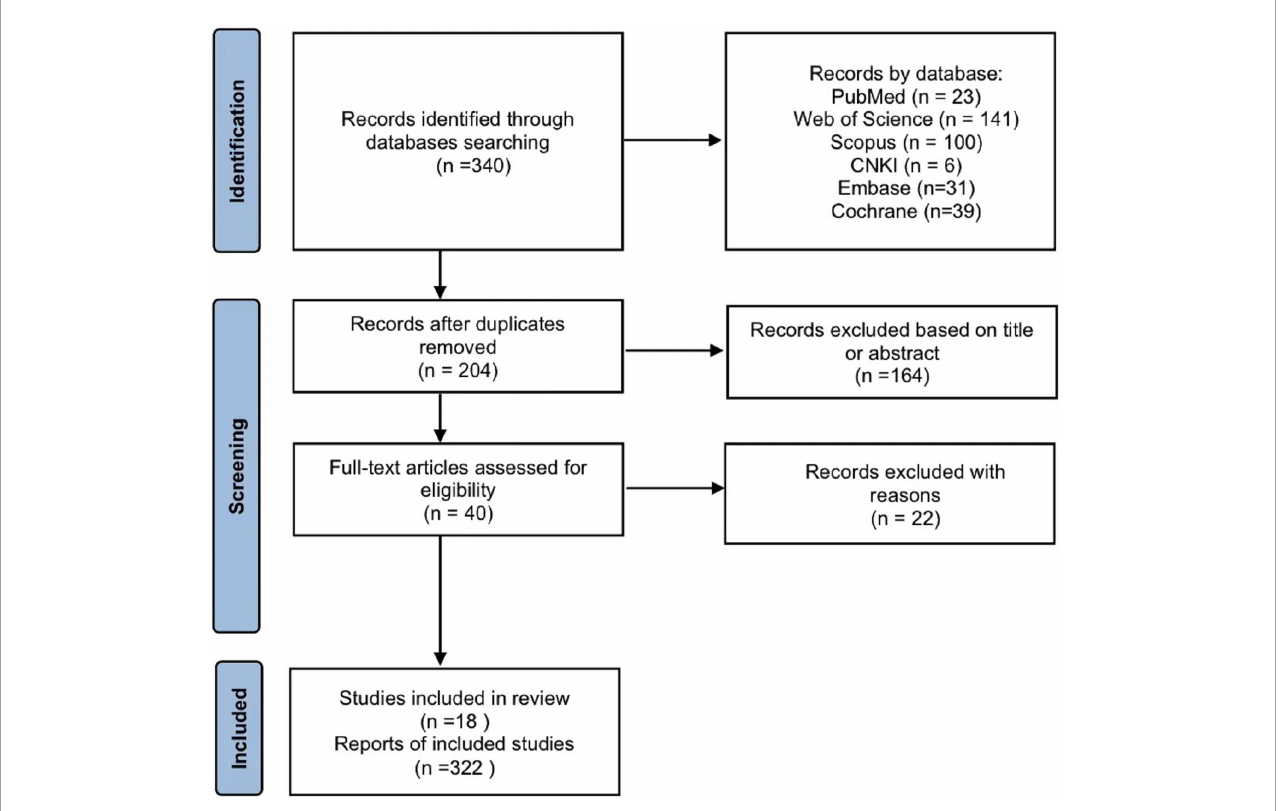
FIGURE3 Flowchart representing the process of article